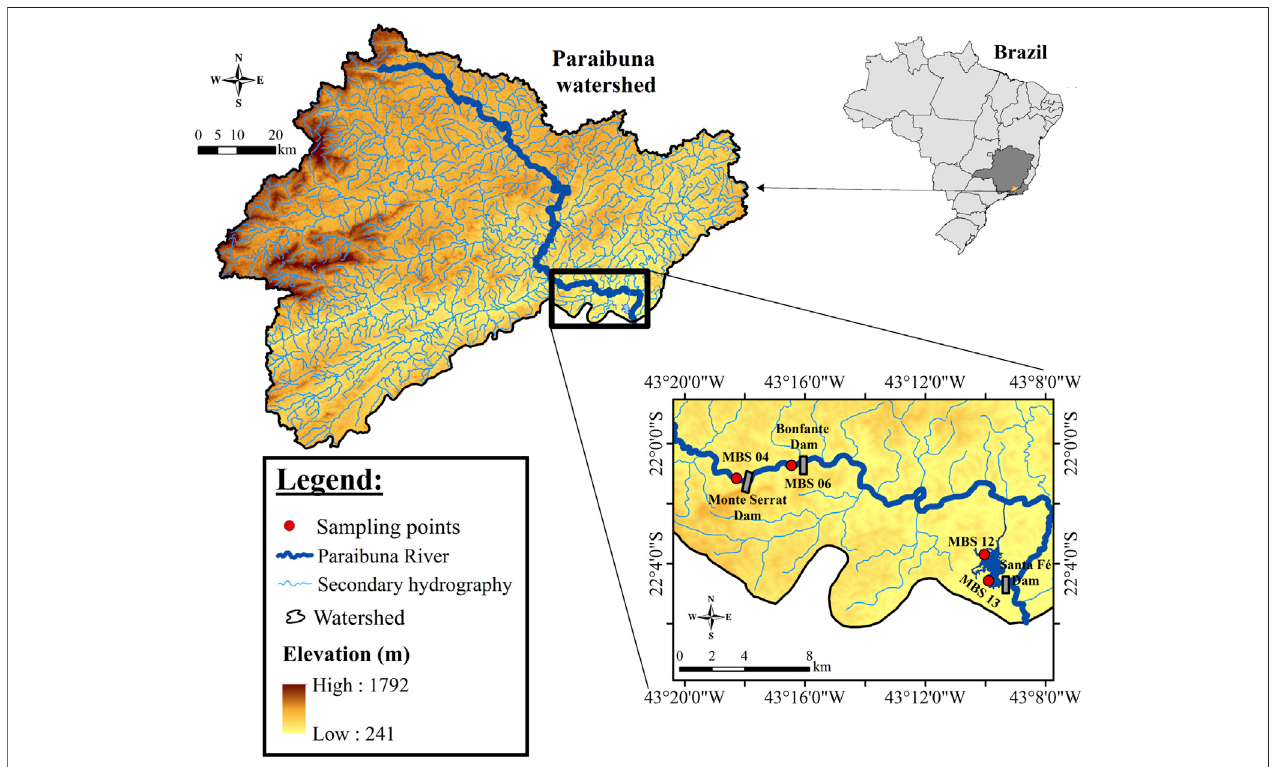
FIGURE1| MapofthestudyareadisplayingthelocationofthethreeSmallHydroelectricPowerPlant(SHP)reservoirs:MonteSerrat,BonfanteandSantaFéalong the Paraibuna River. The red dots represent the sampling stations: MBS04 — Monte Serrat, MBS06 — Bonfante, MBS12 — Santa Fé I and MBS13 — Santa Fé II.